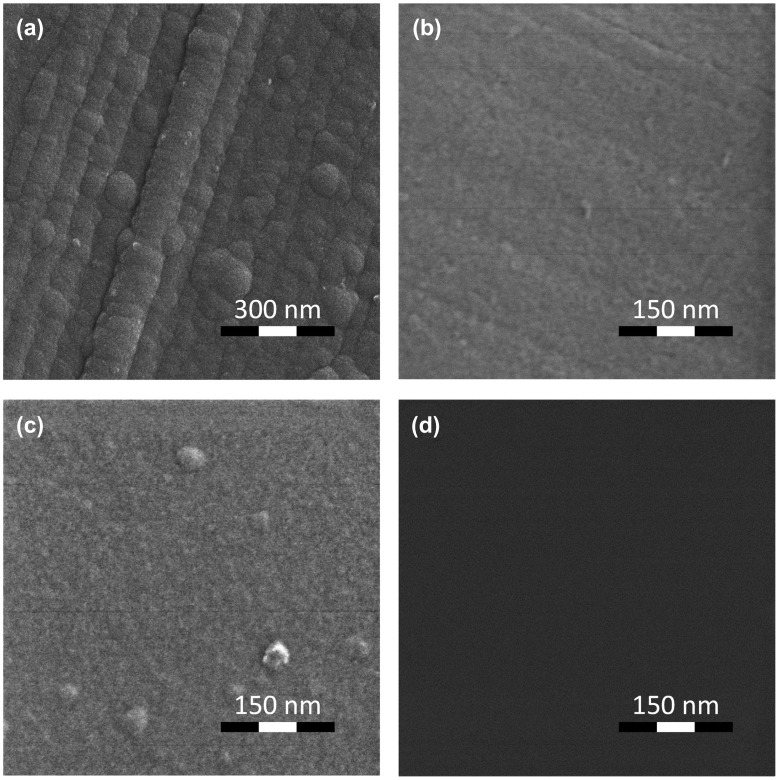
 HIM image of TiO2 film deposited on (a) Al/ITO and (c) deg-Si/ITO substrates and of an Al substrate (b) and a deg-Si substrate (d).